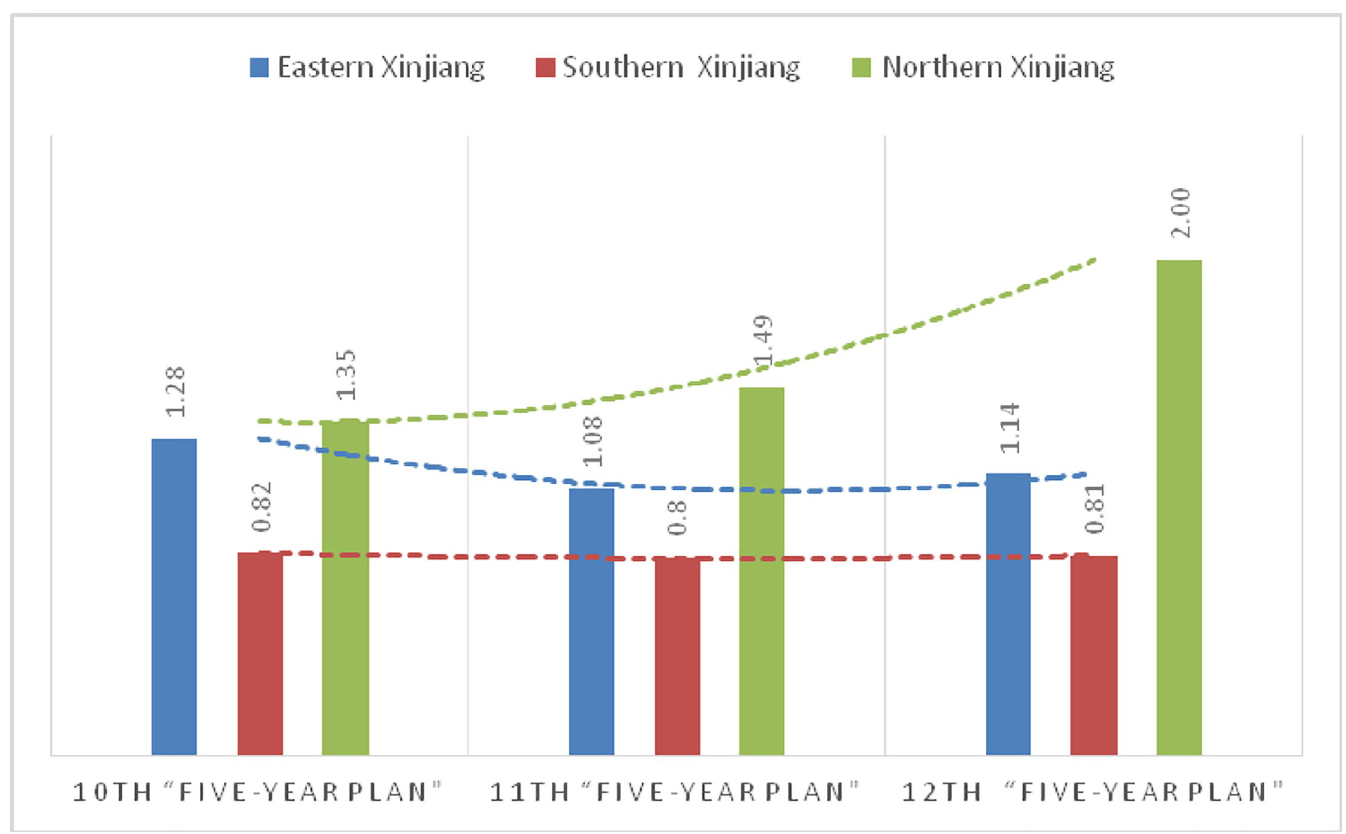
Fig 5. Variation trend of eco-efficiency during the “Tenth Five-Year Plan” to the “Twelfth Five-Year Plan”.